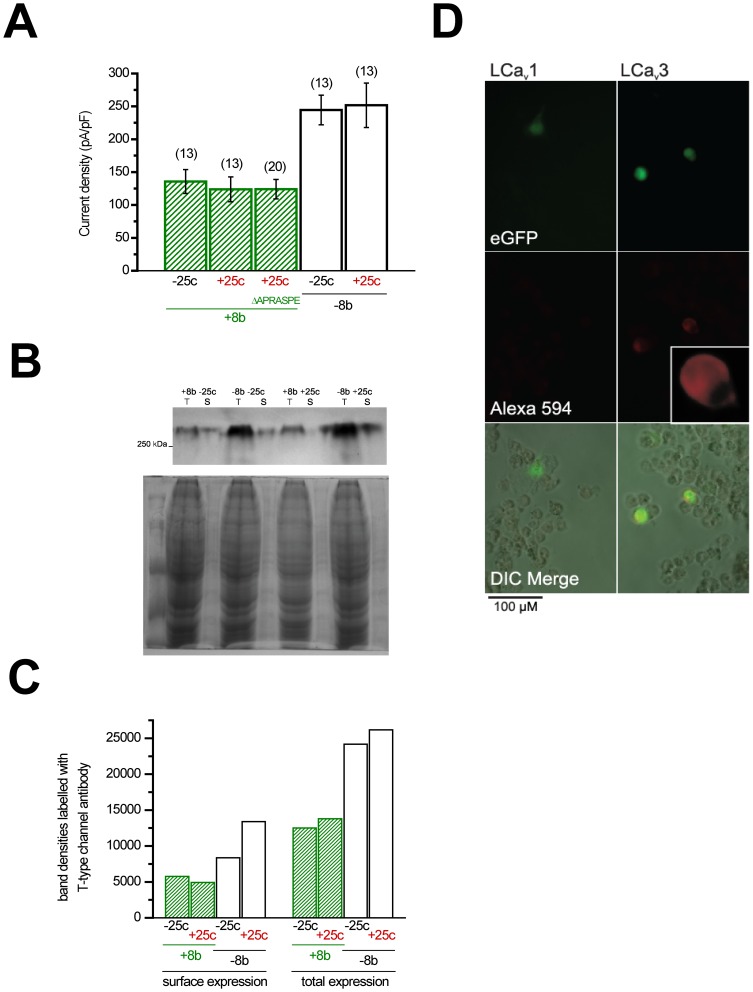
Changes in total and membrane expression of snail LCav3 T-type channel in response to the presence or absence of optional exons 8b and 25c.(A) Current density (pA/pF) of peak calcium currents in the presence of optional exons (n = 13 for each variant), including a +8b −25c variant without the APRASPExxD motif (n = 20). (B) Top: Western blot showing biotinylation-mediated fractioning of surface-expressed proteins, revealing that LCav3 variants lacking exon 8b are more abundantly expressed in total protein extracts (T) of HEK-293T cells, and have corresponding increases in membrane expression (S). Bottom: Coomassie-stained replicate SDS-PAGE gel as the one used in the above blot, showing equal protein levels from the different HEK-derived total protein and surface protein extracts. (C) Densinometric quantification of bands visible on the Western blot indicates that −8b variants are ∼2-fold more abundant in both total protein and surface-expressed protein fractions. Notably, LCav3 channel membrane expression is quite high in HEK cells (∼50% of total), regardless of splice variability in exons 8b and 25c. (D) Immunolabeling of HEK-293T cells transfected with pIRES2-EGFP expression constructs containing either LCav3 (+8b −25c) or LCav1 cDNA confirms specific membrane-delimited staining for LCav3, with no labelling of LCav1-transfected cells using α-LCav3 polyclonal antibodies.